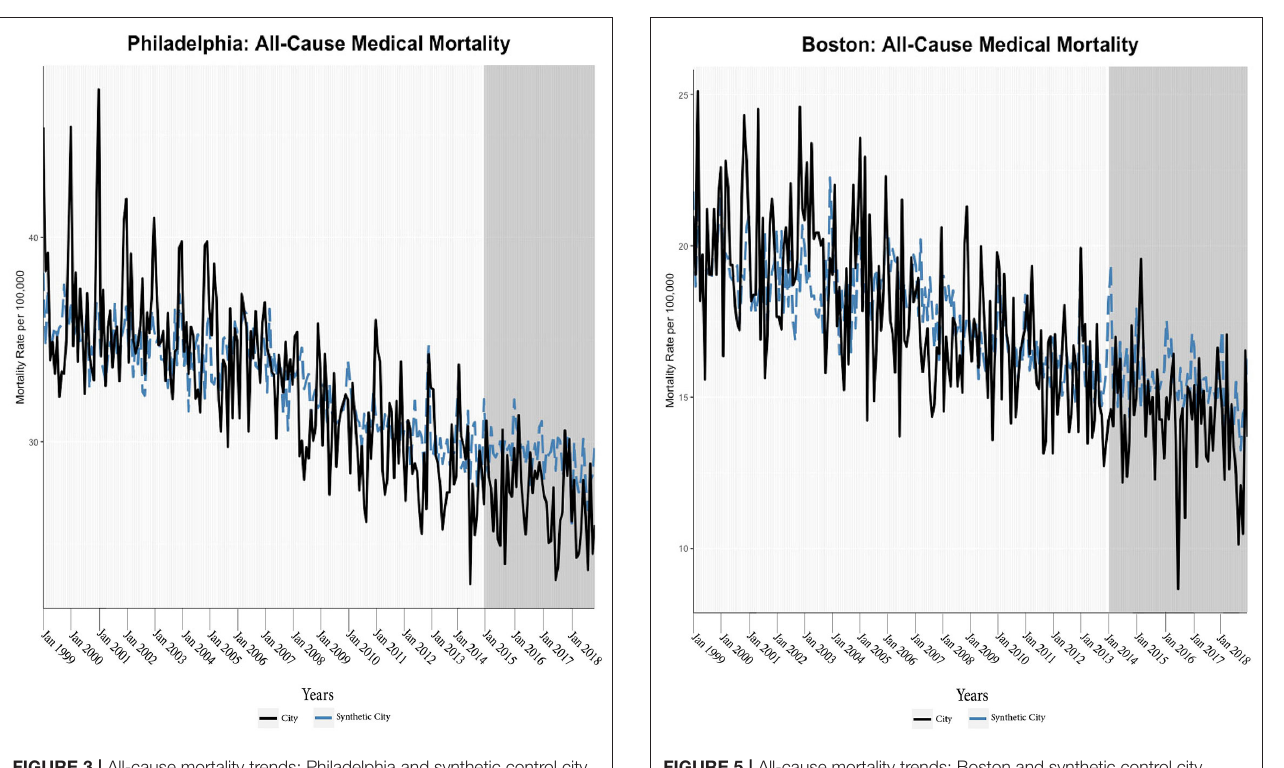
FIGURE 3 | All-cause mortality trends: Philadelphia and synthetic control city.